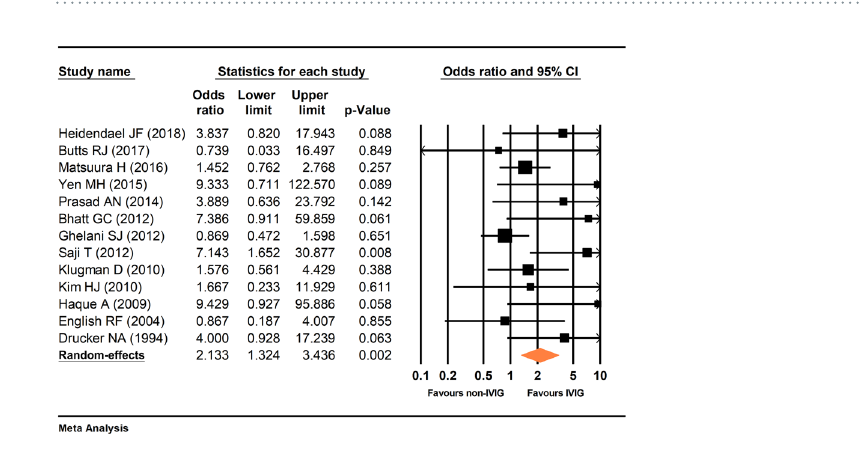
Figure 4. Forest plot. Comparison of survival rate between patients with IVIG and the control group.